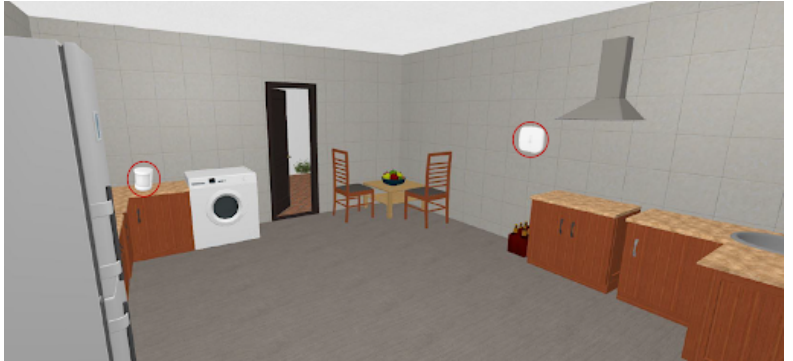
Figure 26. Sensors in the kitchen.